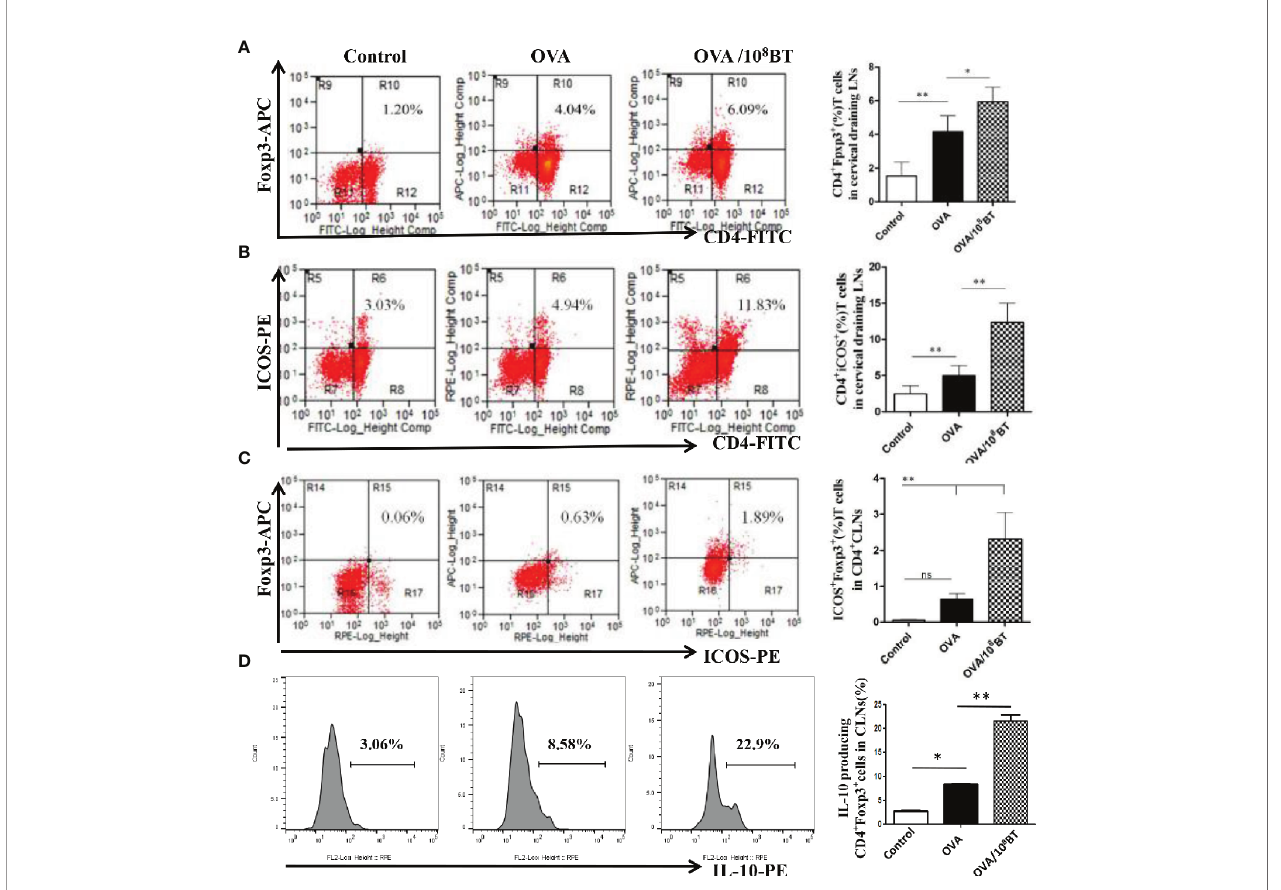
FIGURE 7 | B. thetaiotaomicron induced ICOS expression on Tregs and ampli fi cation of IL-10-expressing CD4 + Foxp3 + Tregs in draining cervical LNs. Representative scatter plots and ration of the fraction of CD4 + Foxp3 + cells (A) , CD4 + ICOS + T cells (B) and CD4 + ICOS + Foxp3 + regulatory T cells (C) . Representative histogram showing expression of IL-10 in CD4 + Foxp3 + Tregs (D) . Bar graphs represent mean ± SD. n = 6, * P < 0.05, ** P < 0.01. ns, no signi fi